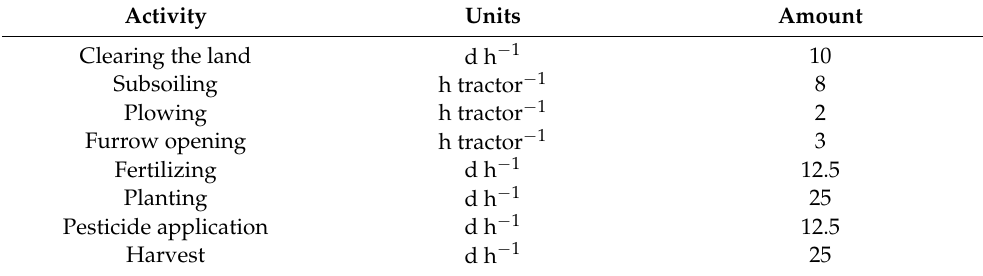
Table 7. Data for calculation of E MO